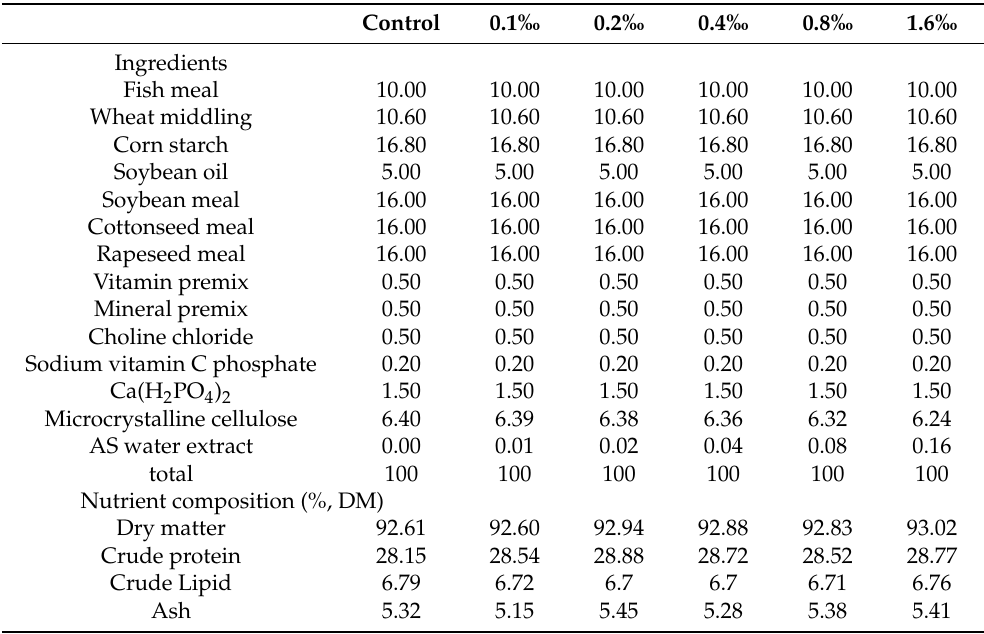
Table 1. Feed formulae of experimental diets (containing 0‰, 0.1‰, 0.2‰, 0.4‰, 0.8‰, and 1.6‰